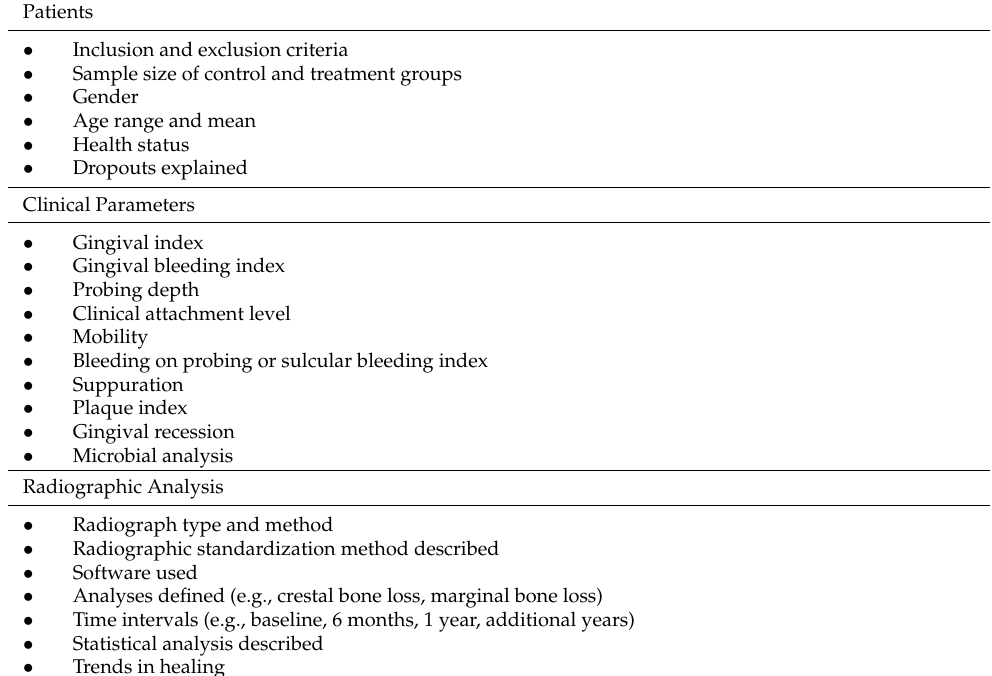
Range of Variables That May Apply to Laser-Based Studies of Peri-Implantitis Treatment